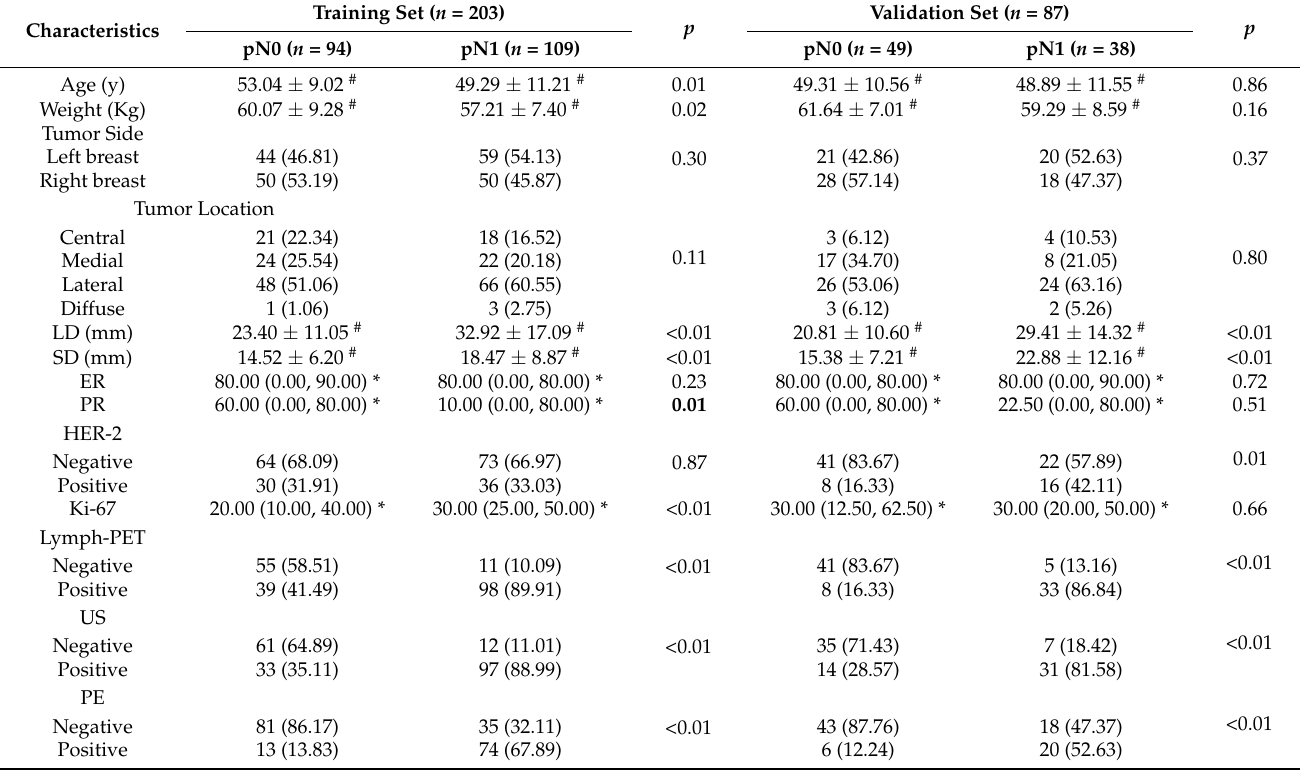
Table 1. Demographic and clinicopathologic characteristics of early-stage breast cancer